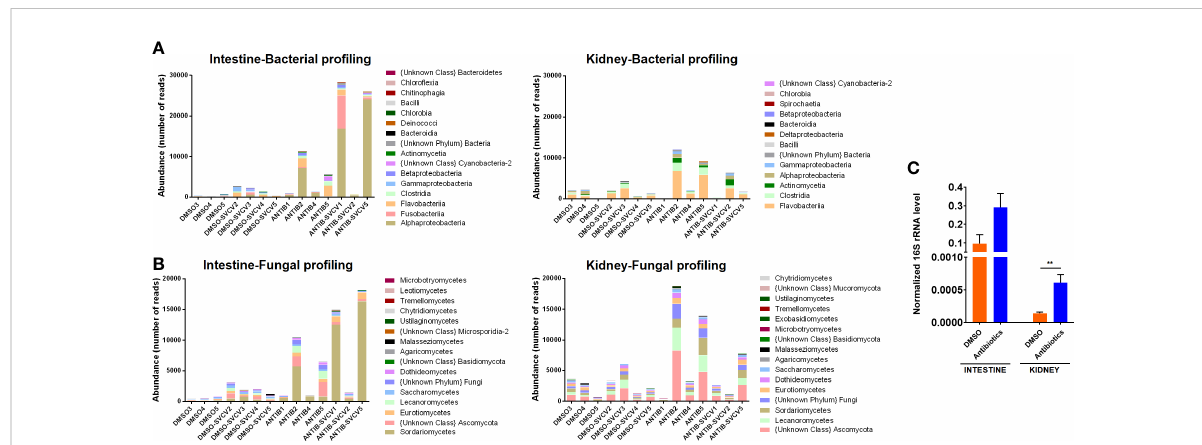
FIGURE 1 Microbiota abundance. Absolute abundance of the main (A) bacterial and (B) fungal classes in intestine and kidney samples from zebra fi sh exposed to SMX+CLA or the vehicle alone and infected or not with SVCV. (C) The total abundance of bacteria was measured in the intestine and kidney of uninfected SMX+CLA- or DMSO-treated fi sh by qPCR detection of the 16S rRNA using the universal primer pair PSL-PSR. Statistically signi fi cant differences are displayed as **